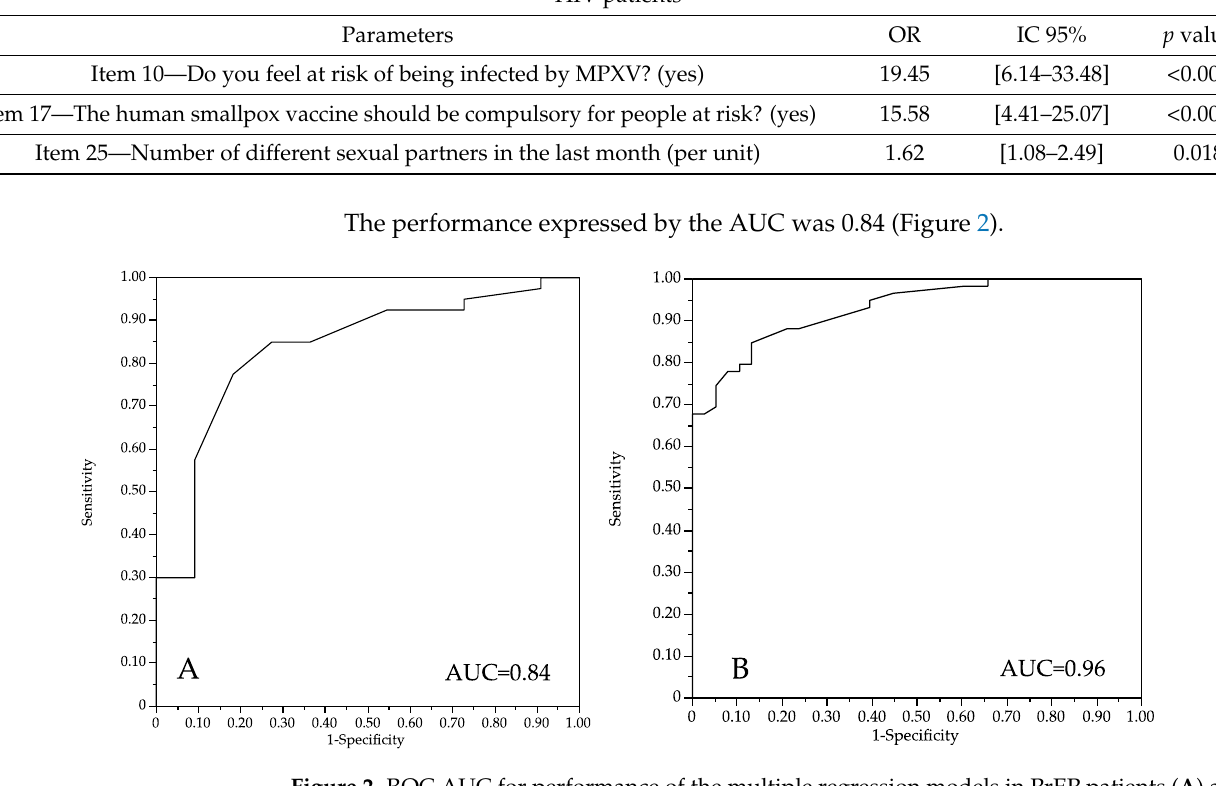
Figure 2. ROC AUC for performance of the multiple regression models in PrEP patients ( A ) and in HIV patients ( B HIV patients ( B ).